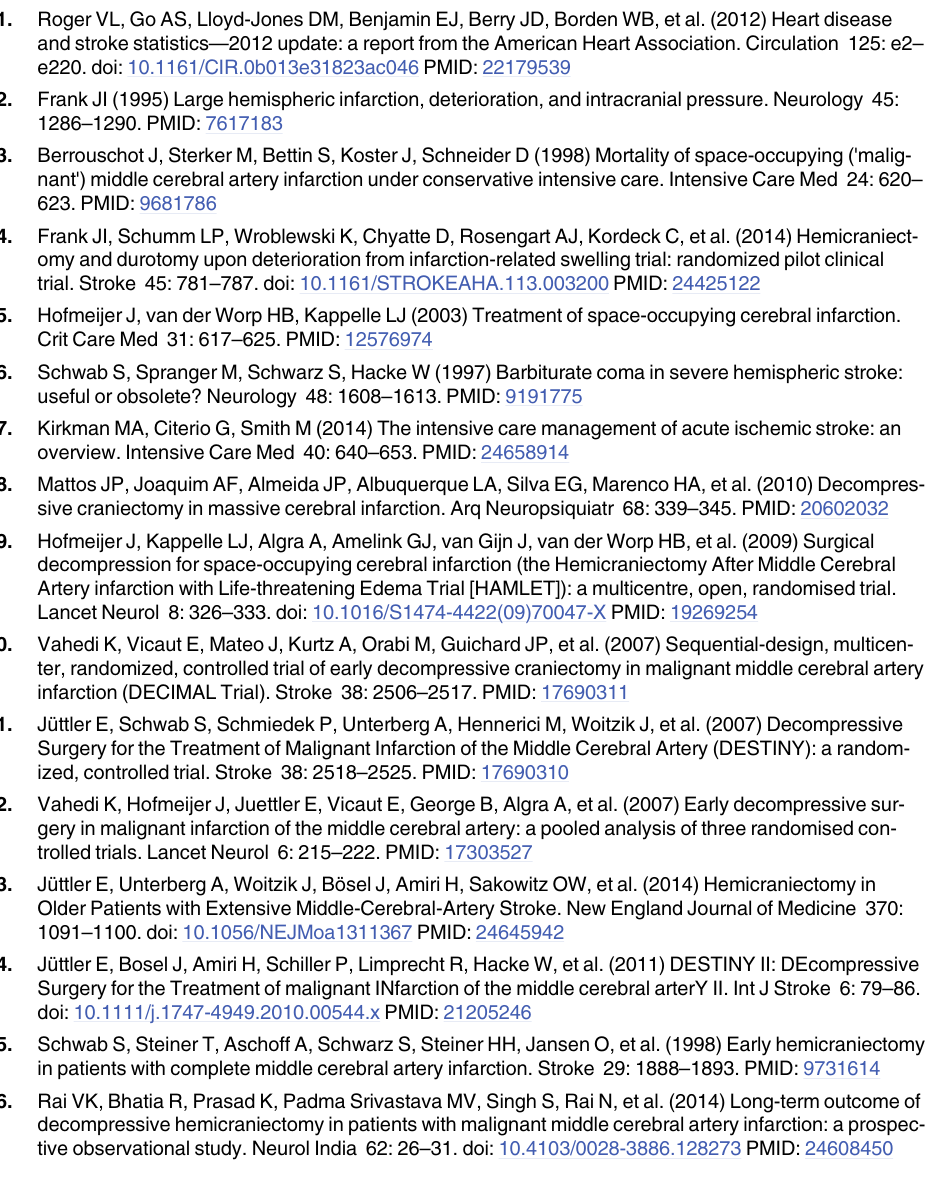
S1 Table. Supporting patient data